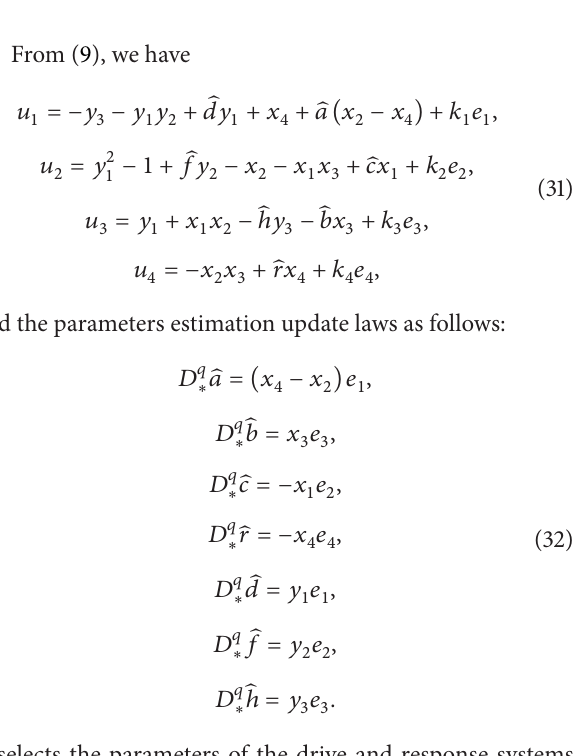
Figure 2: Time evolution of parameter estimations for system (27).